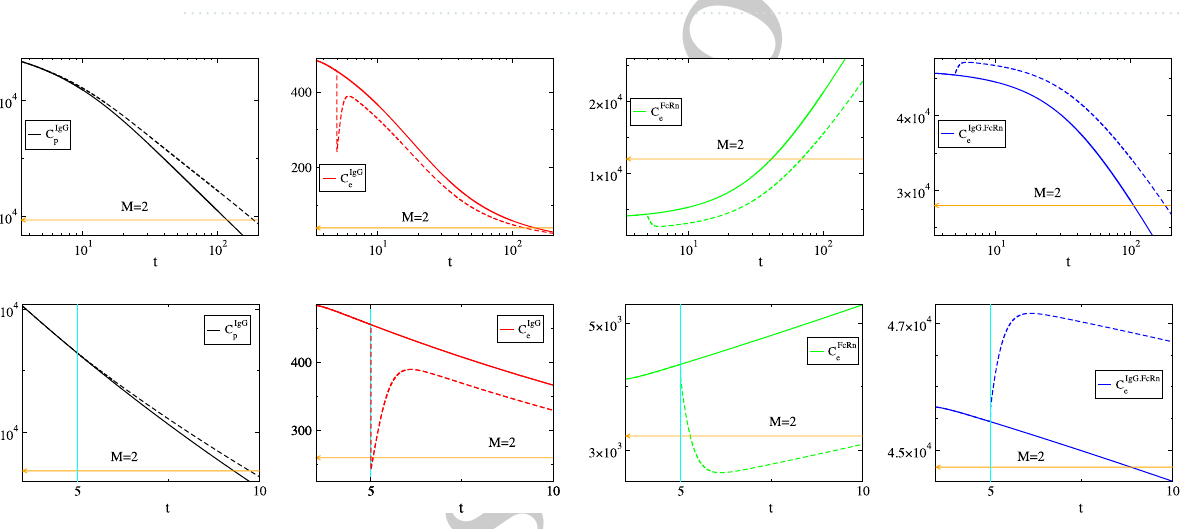
Figure 8. Concentration profiles for the reference case (parameter values in Table 1, solid curves) and for the case in which the reaction rate constant of R 3 f is doubled (dashed curves). The perturbation is enforced from t = 5 h , as indicated by the vertical line. The indicated M = 1 and M = 2 periods refer to the reference